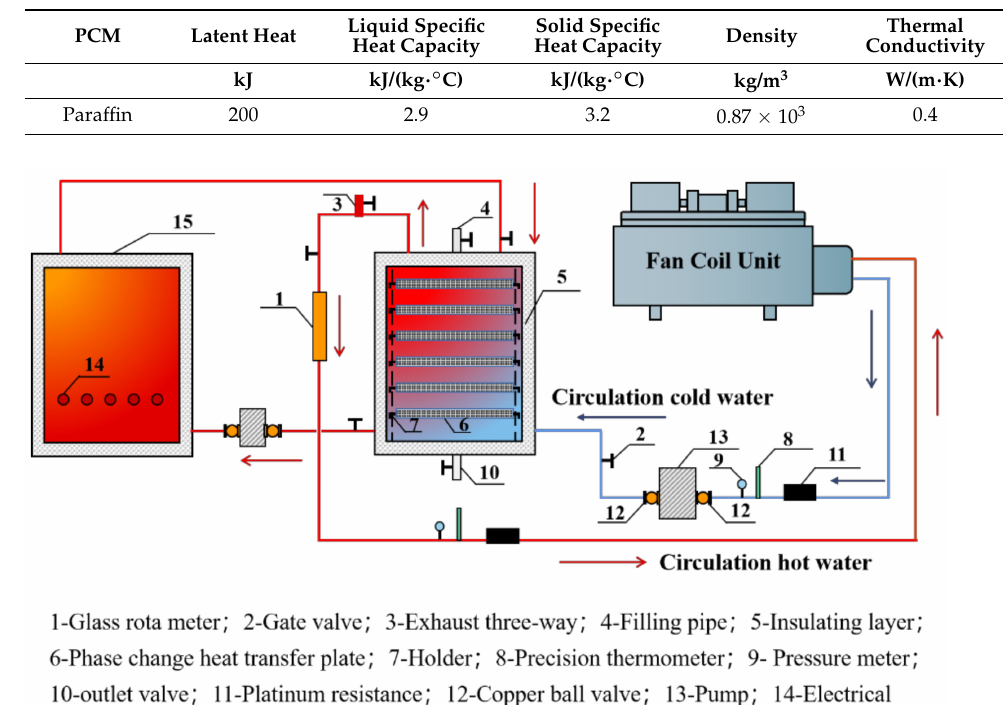
Figure 3. Schematic diagram of PCM storage tank heating system.